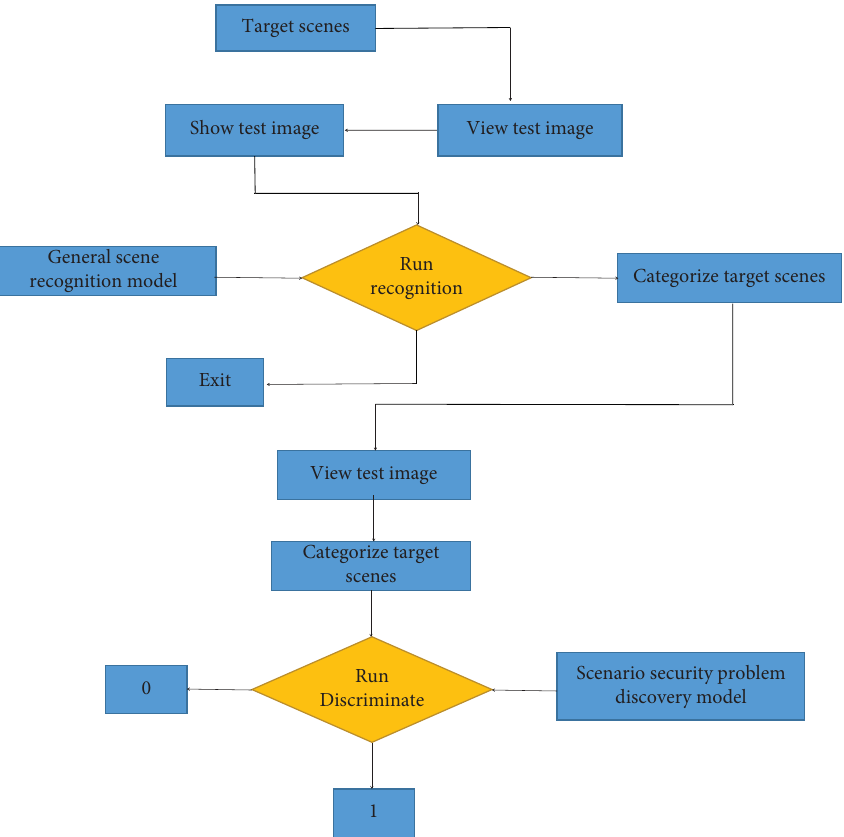
Figure 8: Construction site safety problem discovery system